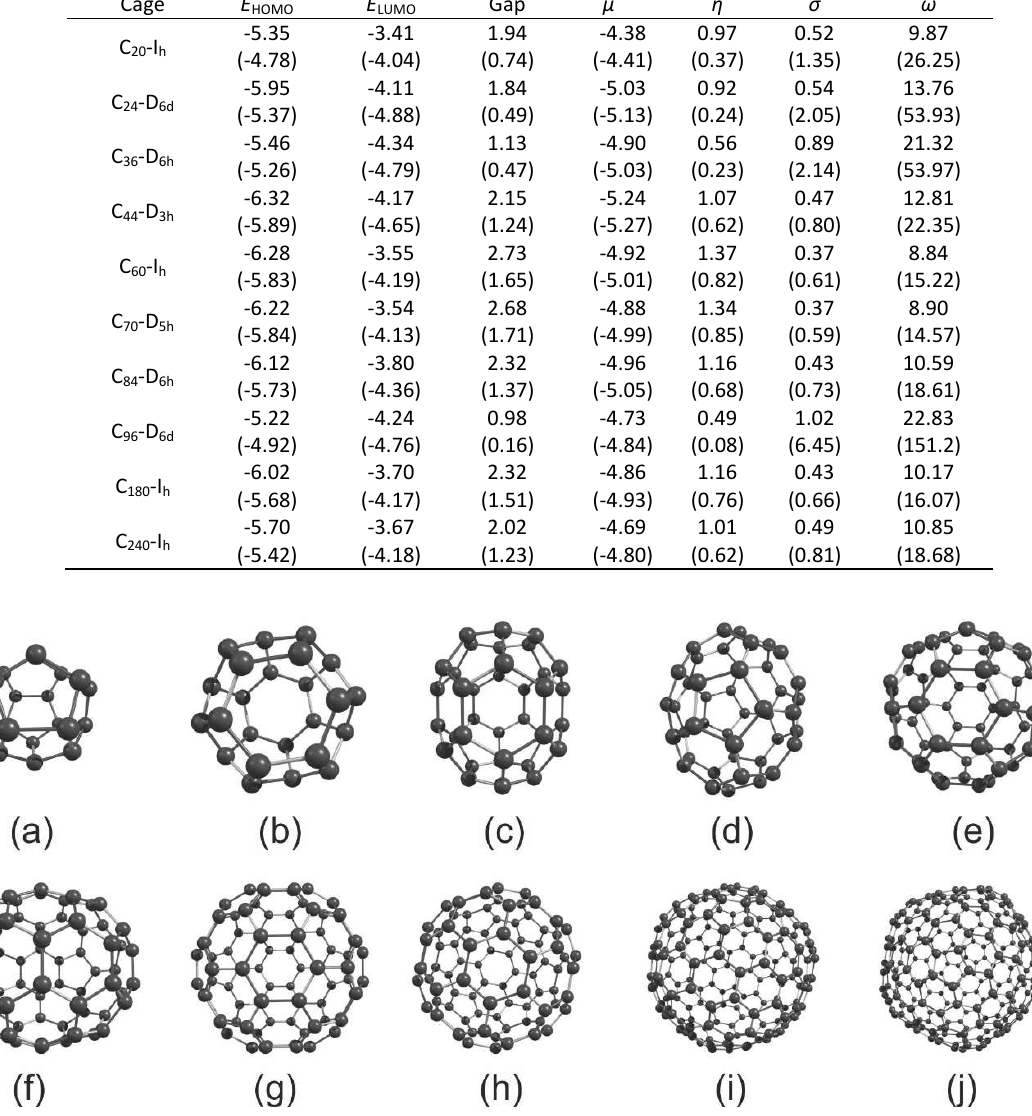
Energies of frontier orbitals EHOMO and ELUMO (eV), HOMO-LUMO gaps (eV), chemical potentials μ (eV), chemical hardness η (eV) and softness S (eV–1) and electrophilicity indexes ω (eV) of carbon fullerenes calculated at B3LYP/6-311G** level of theory. Results obtained at PBE/6-311G** level of theory are given at parenthesis.